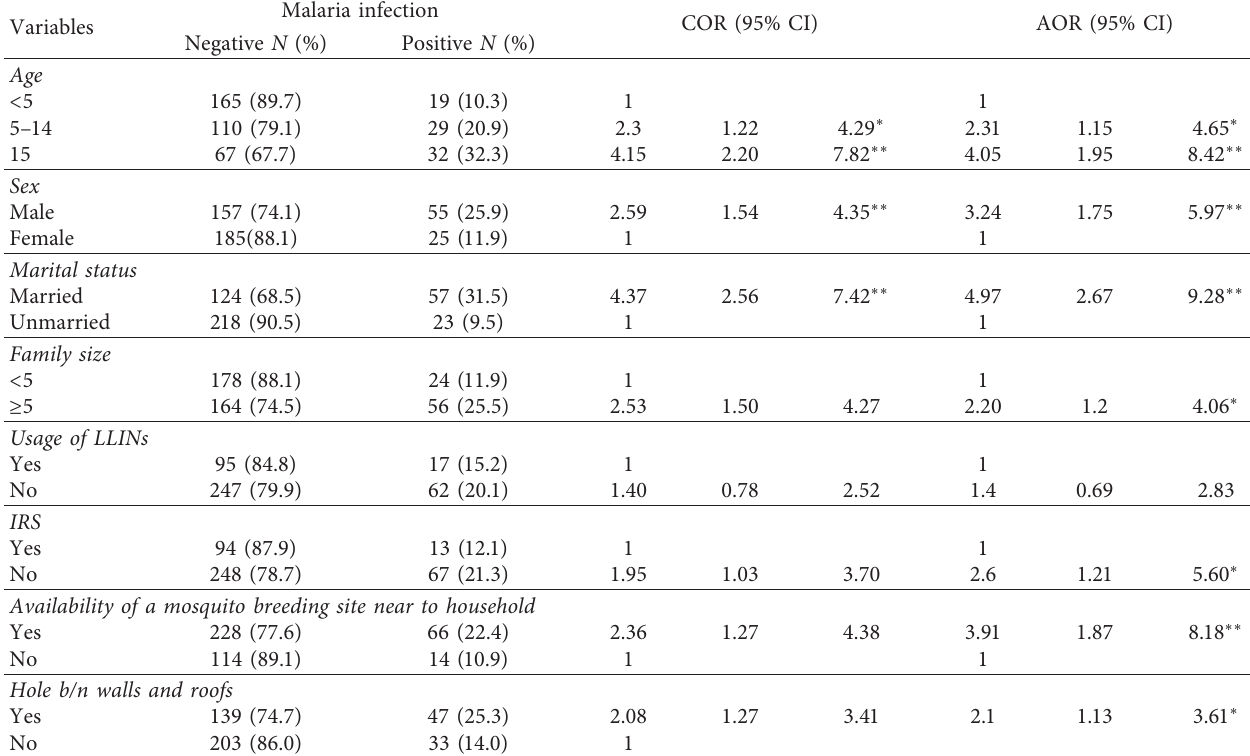
Table 4: Bivariable and multivariable logistic regression analysis of malaria incidence and associated risk factors in Shewa Robit, Ethiopia ( n �